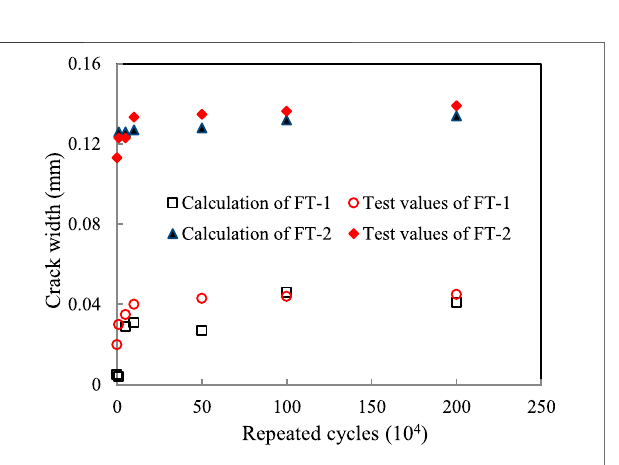
Frontiers in Materials |